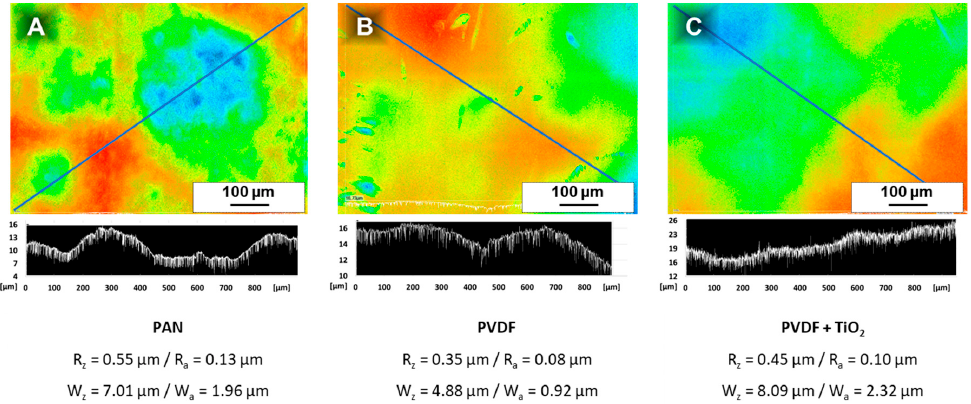
Figure A6. Laser scanning microscopic (LSM) images of the used support membranes PAN ( A ), PVDF ( B ) and PVDF + TiO 2 ( C ). Calculations of roughness R z and waviness W z were performed over a distance of 950 µm (marked with a blue line). The profile along the selected part is shown below each LSM image.